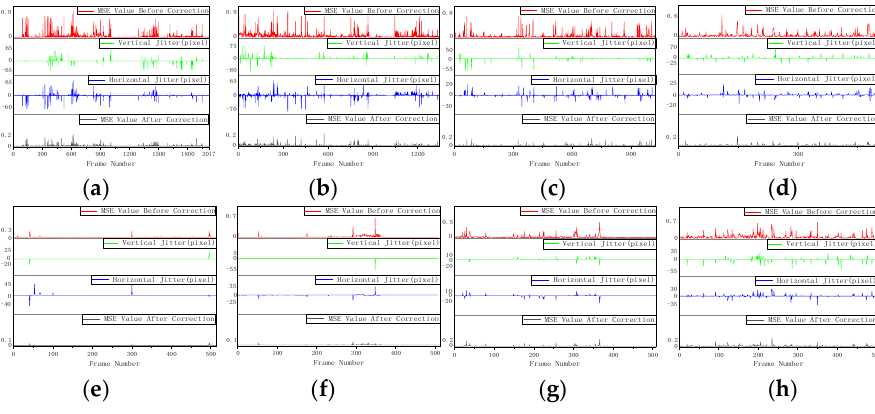
Figure 19. ( a – h ) is verification results for inter-frame jitter position correction.